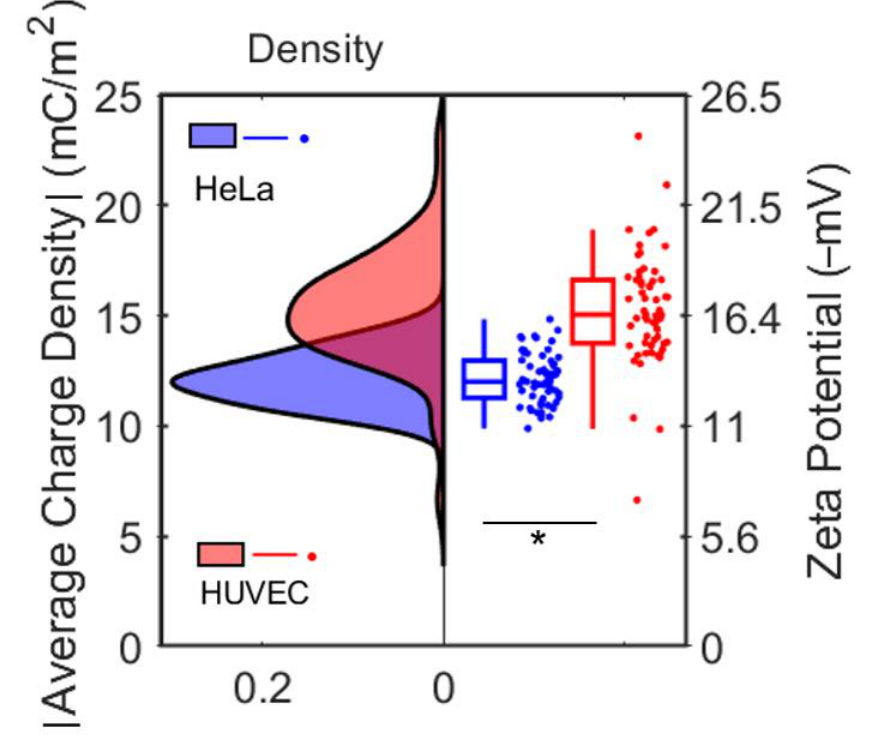
Figure 7. Comparison of the measured average charge density for each cell type, obtained from fluorescence method, and the corresponding zeta potential of HUVEC and Hela cells. Left: distribution of average charge density of cells. Right: boxplot of zeta potential converted from the average charge density of cells. The statistical test showed statistically significant surface charge density difference between Hela cells and HUVEC cells. * p < 0.05 ( n = 60).